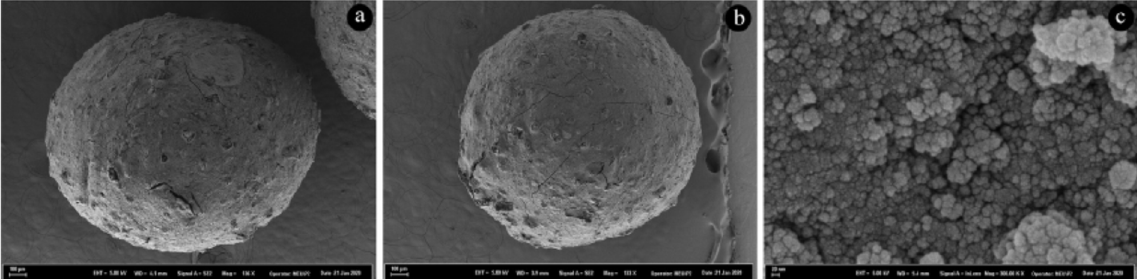
Figure 22. FE-SEM images of Fe 3 O 4 -lignin-chitosan beads ( a ) and Pd NPs@Fe 3 O 4 -lignin-chitosan ( b , c )